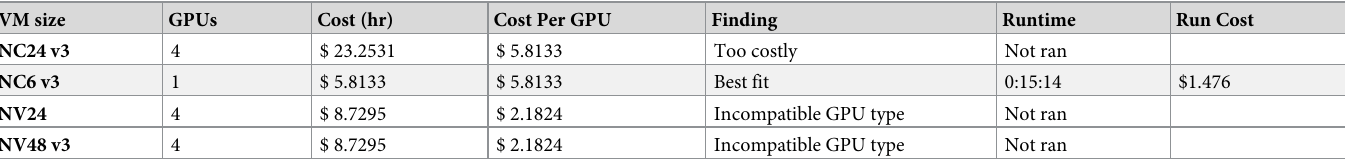
Table 1. GPU VMs that were tested in the validation.